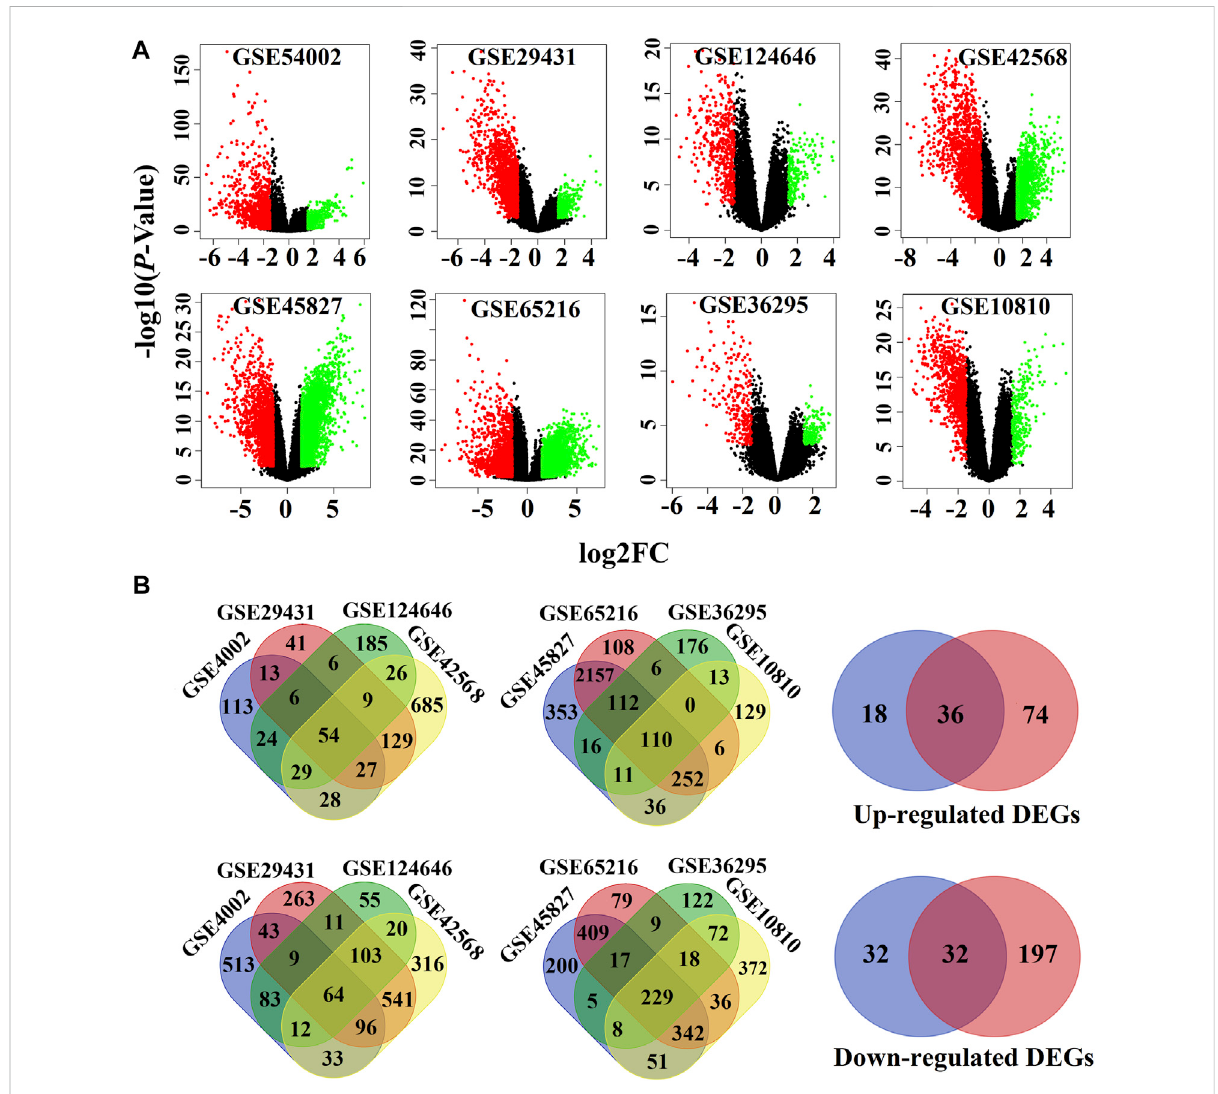
FIGURE 1 Screen of the overlapping DEGs (oDEGs) among eight sets of gene expression pro fi les. (A) Volcano plots of DEGs, where red dots indicate downregulated DEGs and green dots indicate upregulated DEGs. (B) Venn diagrams were used to screen overlapping upregulated and downregulated